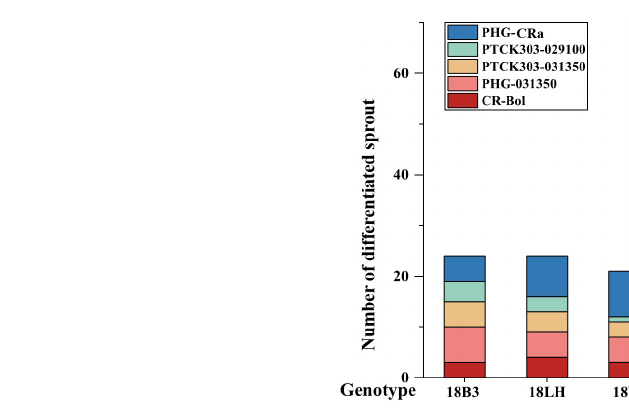
FIGURE 6 The difference in differentiated sprout numbers among 5 broccoli genotypes.